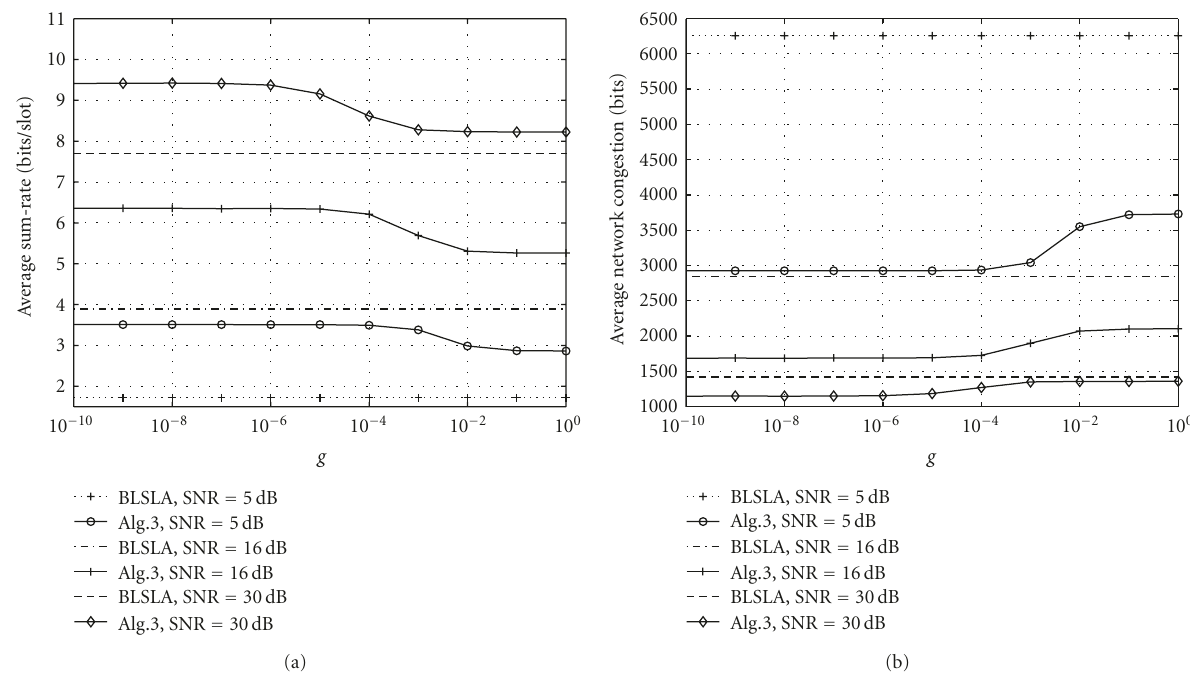
(cid:2) (cid:2) 9 s (a) and of the average network congestion s ∈ S n x n n = 1